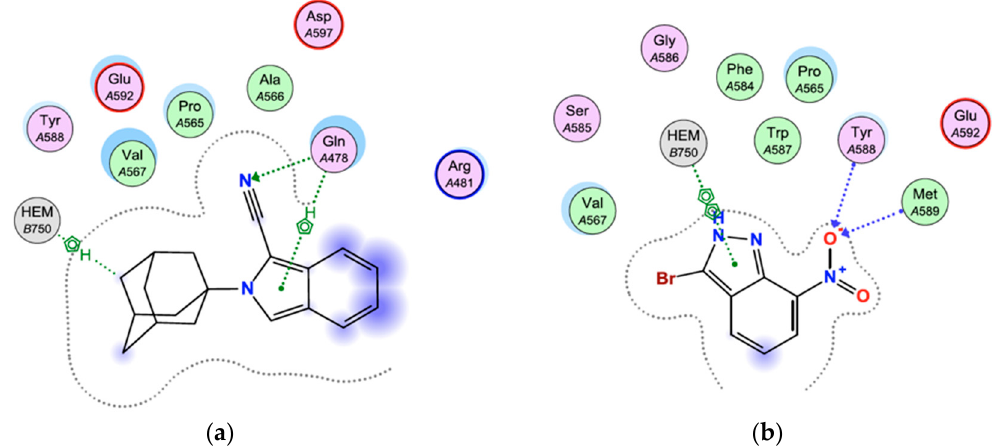
Figure 7. Binding interactions and binding affinity (kcal/mol) of compound 1 and the co-crystallized ligand, 3B7NI, within the active site of the nNOS heme domain. ( a ) Binding affinity ( 1 ) = − 5.722 kcal/mol, ( b ) Binding affinity (3B7NI) = − 6.000 kcal/mol.